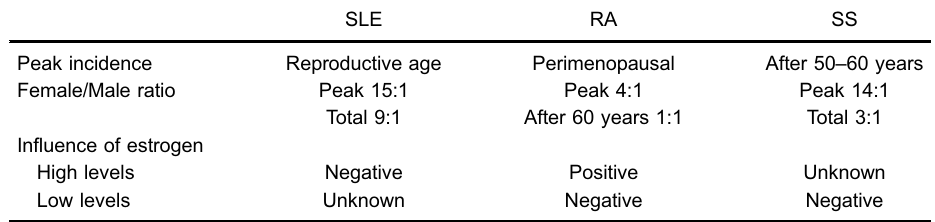
Table 2. Sex differences in the incidence and severity of autoimmune diseases. SLE RA SS Peak incidence Reproductive